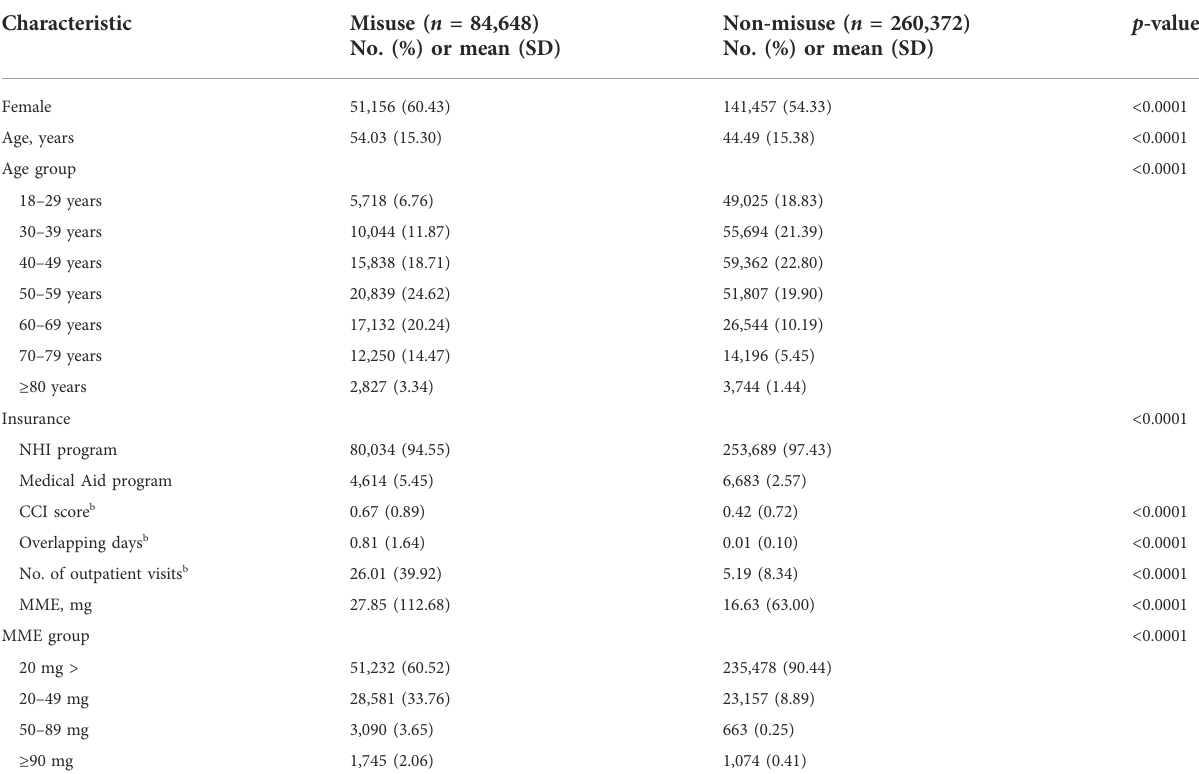
TABLE 1 Baseline characteristics of the study population.